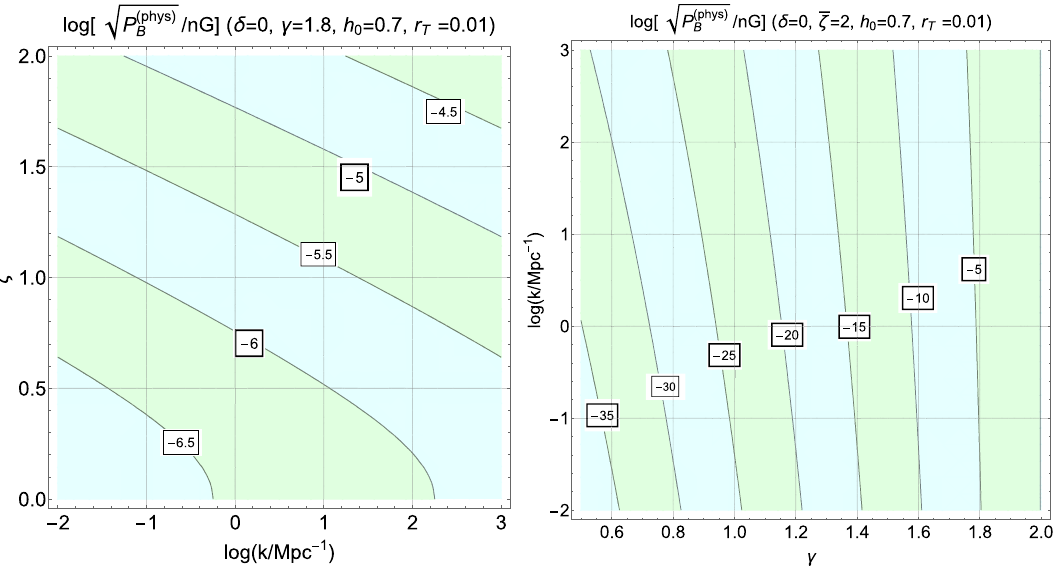
Fig. 7 The parameter space is illustrated in the case of increasing gauge coupling and for different comoving scales. As in the previous plots the numbers appearing on the various contours correspond to the common logarithm of